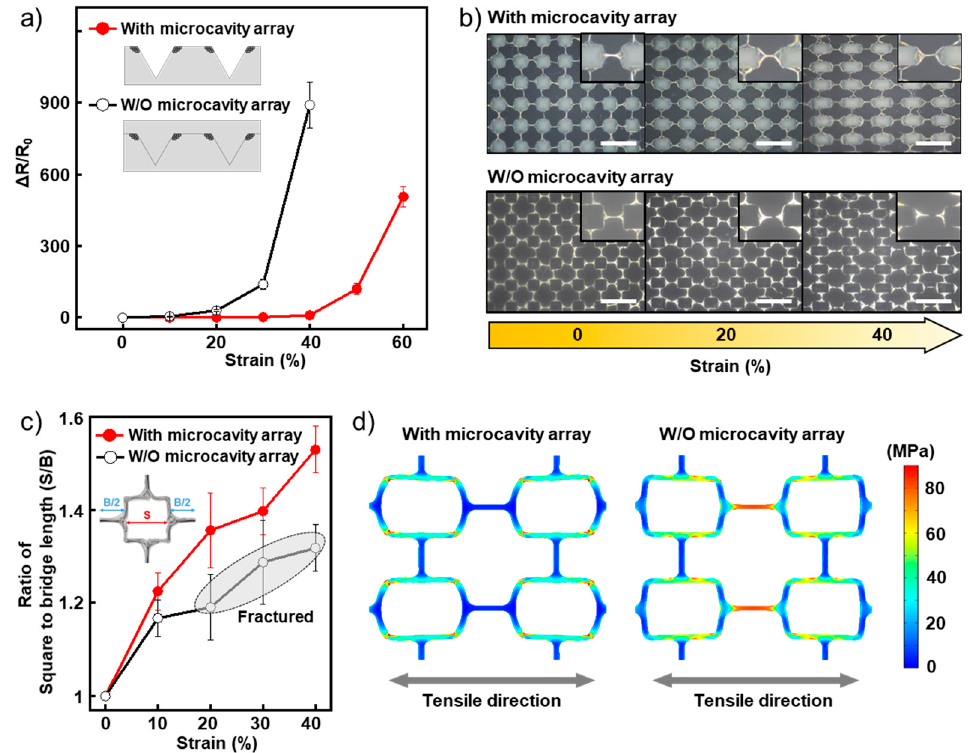
Figure 3. ( a ) Relative resistance change ( ∆ R/R 0 ) in the stretchable electrodes with or without microcavity array under stretching. ( b ) Optical microscopic images of stretchable electrodes during stretching. Scale bar: 30 µ m. Insets are magnified images of bridge regions at each strain value. ( c ) Changes in the ratio of the square to bridge length according to the strain. ( d ) Simulation data of the stretchable electrodes with and without microcavity array under 30% strain.